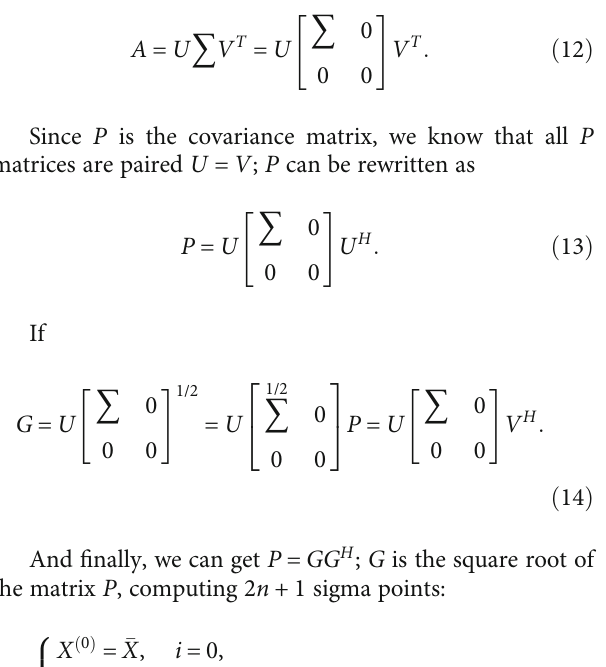
ffiffiffiffiffiffiffiffiffiffiffiffiffiffiffiffiffi n + λ ð ffiffiffiffiffiffiffiffiffiffiffiffiffiffiffiffiffi n + λ